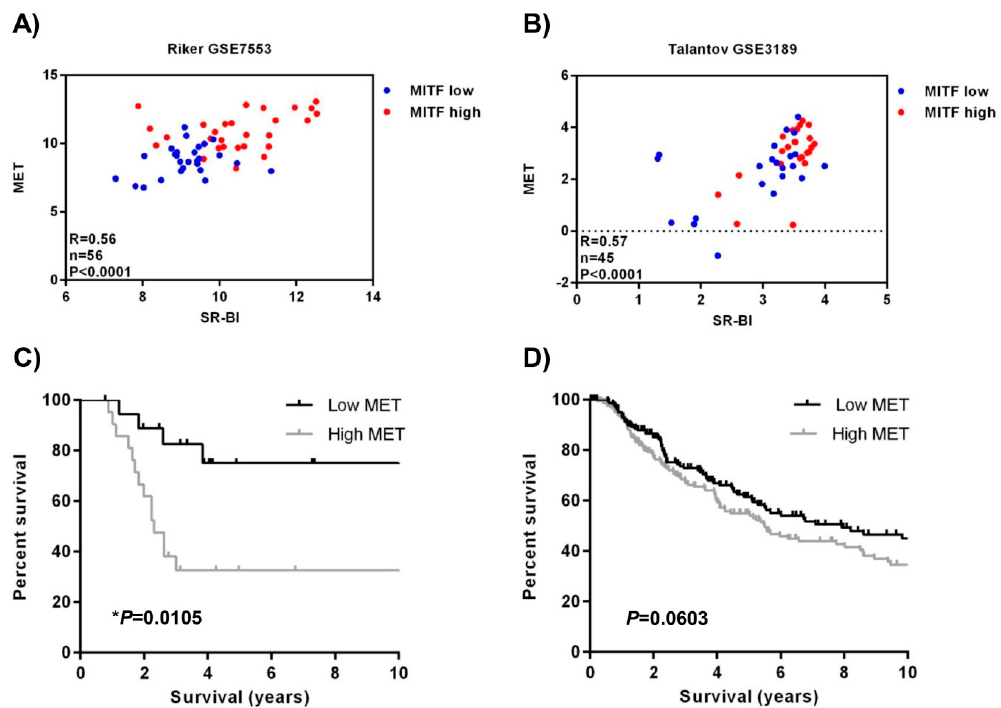
Figure 4. SR-BI and MET correlate in patients. ( A and B ) Patient sample analysis for correlation of SR-BI with MET and additional indication of MITF high expression in red color and MITF low expression in blue color. ( A ) Patient data set GSE7553. ( B ) Patient data set GSE3189. Data sets consisting only of melanoma biopsies, skin tissue and other cancer types were excluded in this analysis. ( C and D ) Ten-year follow-up Kaplan–Meier survival curves of the two data sets ( C ) GSE19234 ( n = 44) and ( D ) SKCM-TCGA ( n = 335). Grey line indicates high MET levels, black line indicates low MET levels. Values were calculated using a log-rank test.